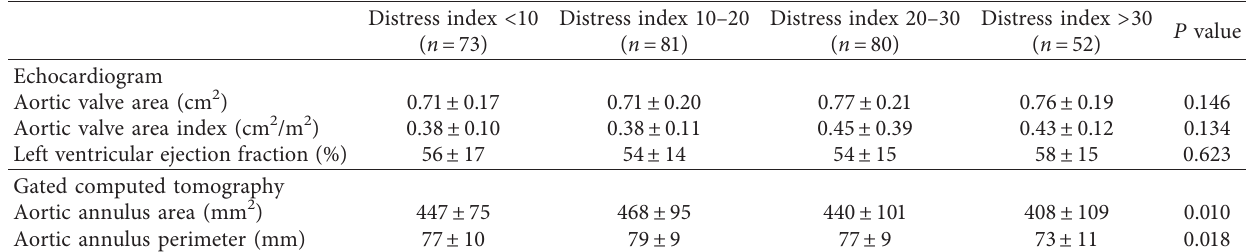
Table 2: Clinical